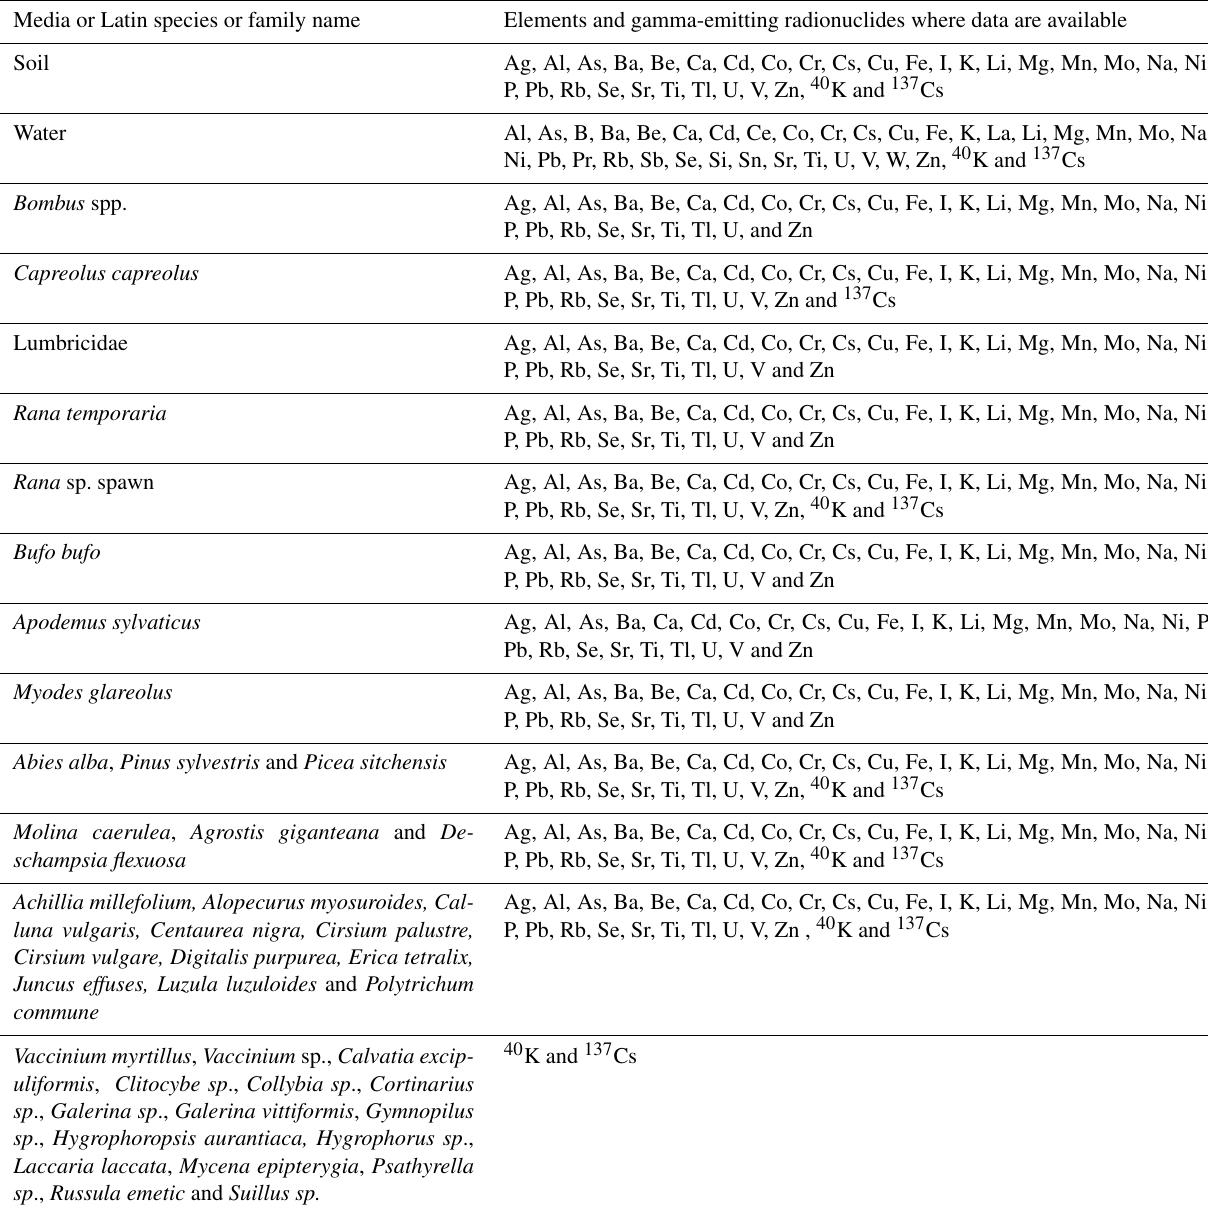
Table A1. Summary of elements and radionuclides for which data are available by sample